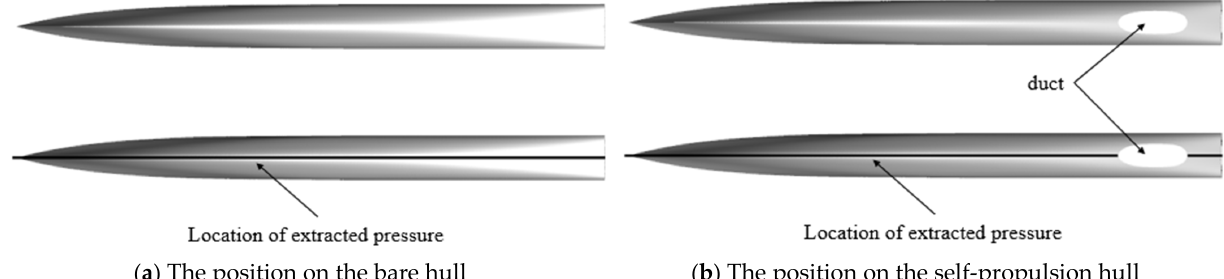
Figure 16. The position of the extracted pressure.